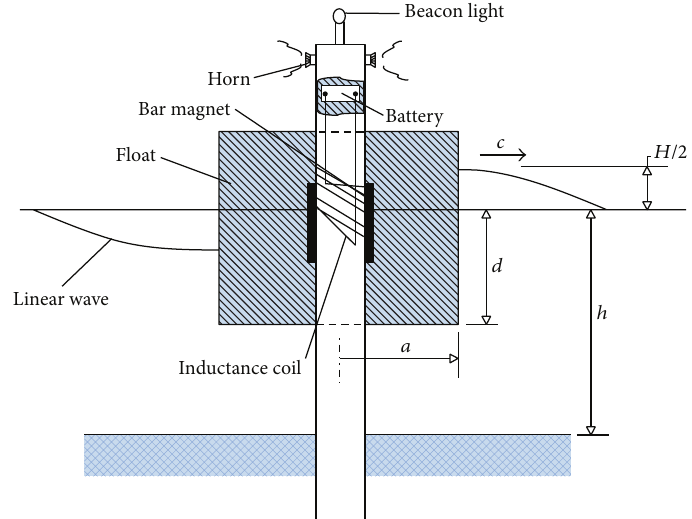
Figure 4: A conventional heaving wave energy harvester